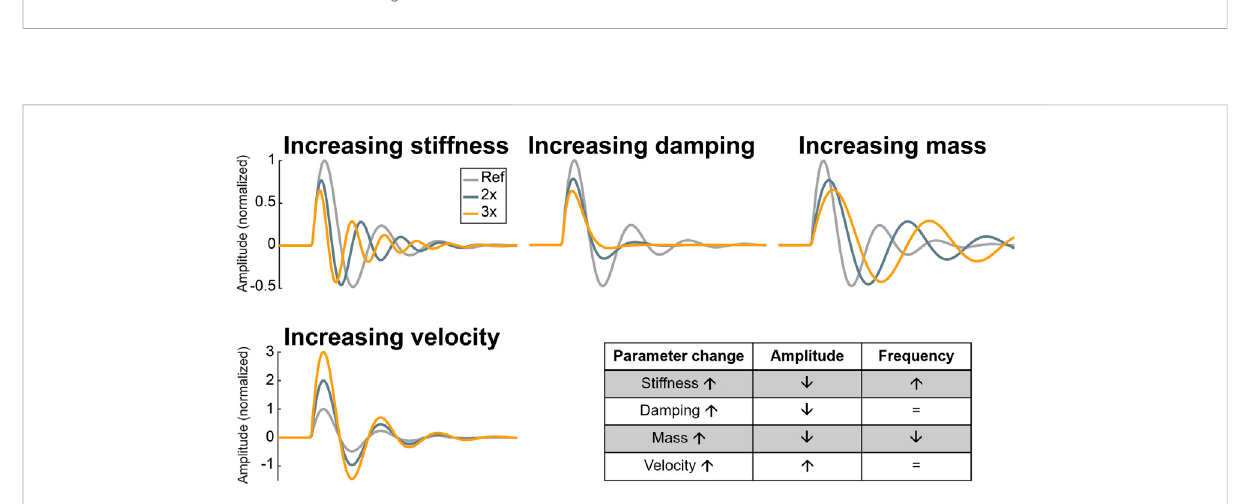
FIGURE 3 (A) S3 relationship with hemodynamic factors at reference. (B) Relation between E wave from Doppler echocardiography and S3 from phonocardiogram (Miranda et al., 2015). Amp, amplitude; FR, fl ow rate; LA, left atrium; LV, left ventricle; P, pressure; RA, right atrium; RV, right ventricle; S3LV, left ventricular S3; S3RV, right ventricular S3.